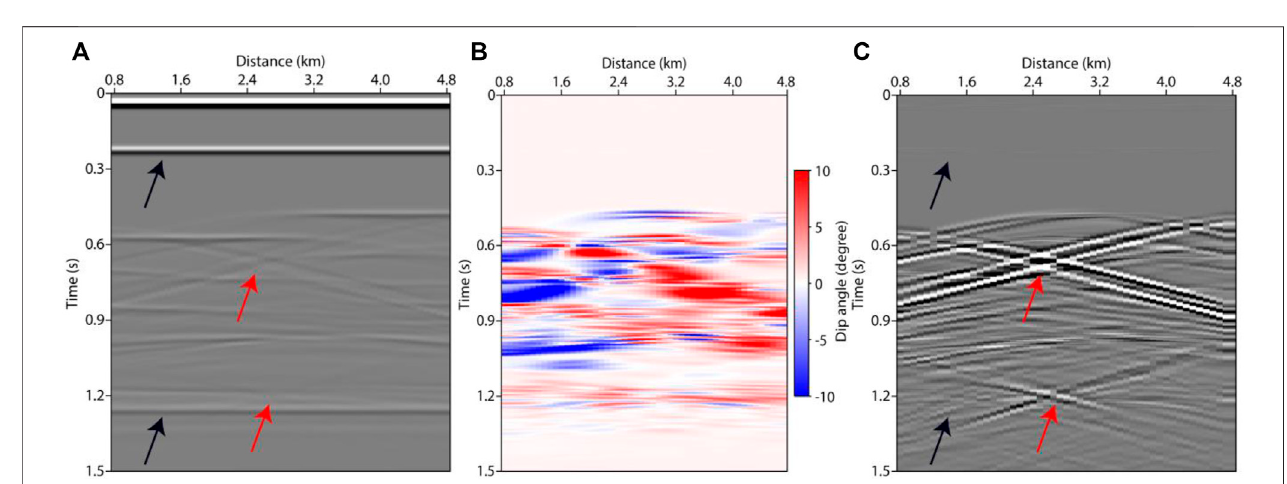
FIGURE 6 | Time sections of the fault model with ray parameter p (cid:1) 0 ms/m. (A) plane-wave section for the full wave fi eld, (B) estimated dip angle fi eld, and (C) plane-wave section for the separated diffraction.